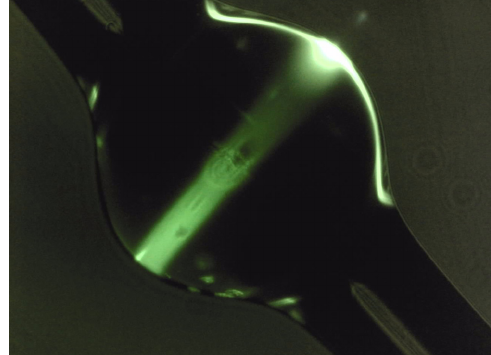
Figure 13. Fluorescence image of the MBR filled with 10 − 3 solution of fluorescein, showing the TPF band and lobes, and the fluorescence coupled back into the MBR wall . Reproduced with modifications from [17].